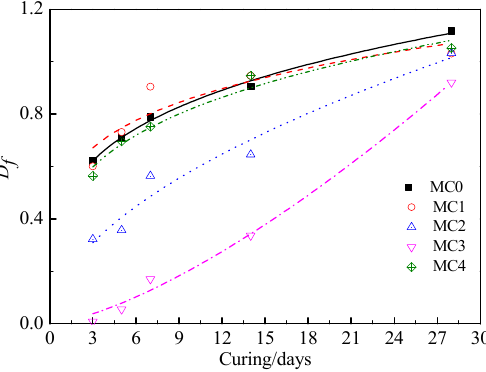
Figure 5. Relationship between fractal dimension and curing age.